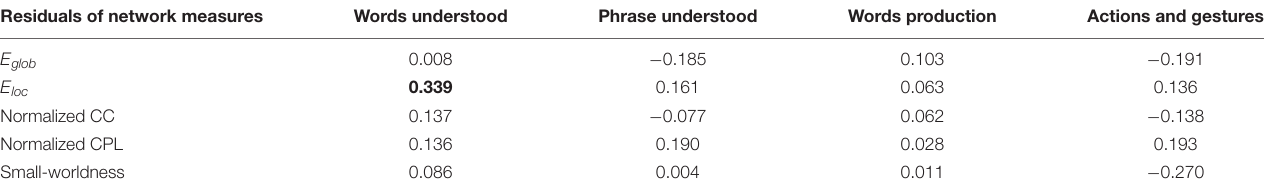
Residuals of network